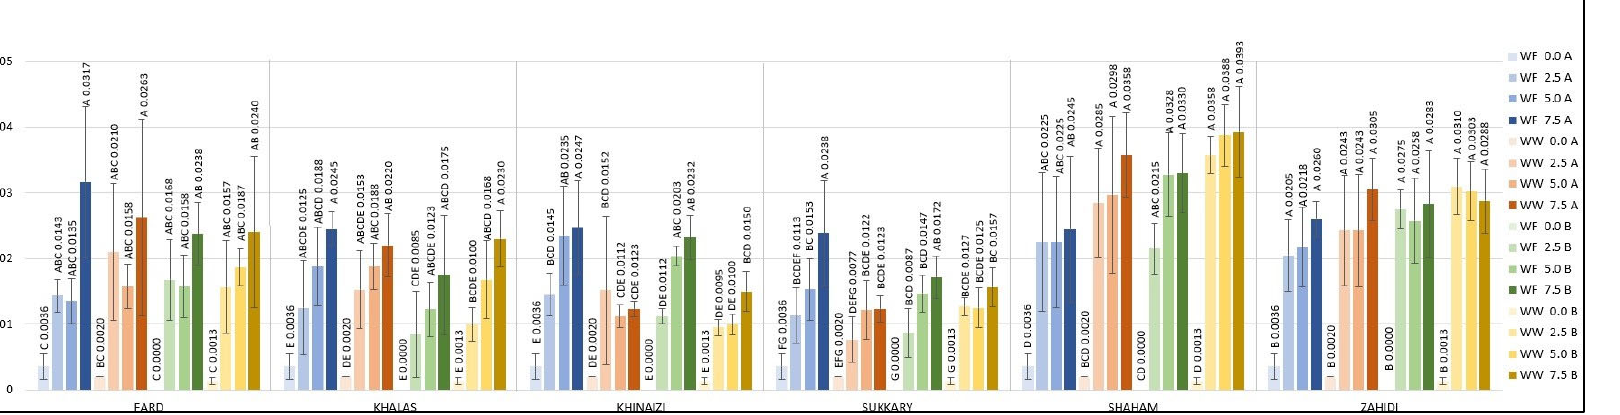
Figure 4. Total contents of Flavonoids of composite cookies formulated with 2.5%, 5%, and 7.5% substitution of flour by date seed powder. (Data expressed as Gallic acid equivalent per gram ( μ g / g) of the cookie sample. Different uppercase superscript letters in a variety denote significant differences, p < 0.05. (A ‐ 180 °C, B ‐ 200 °C).3.3. Antioxidant activity.